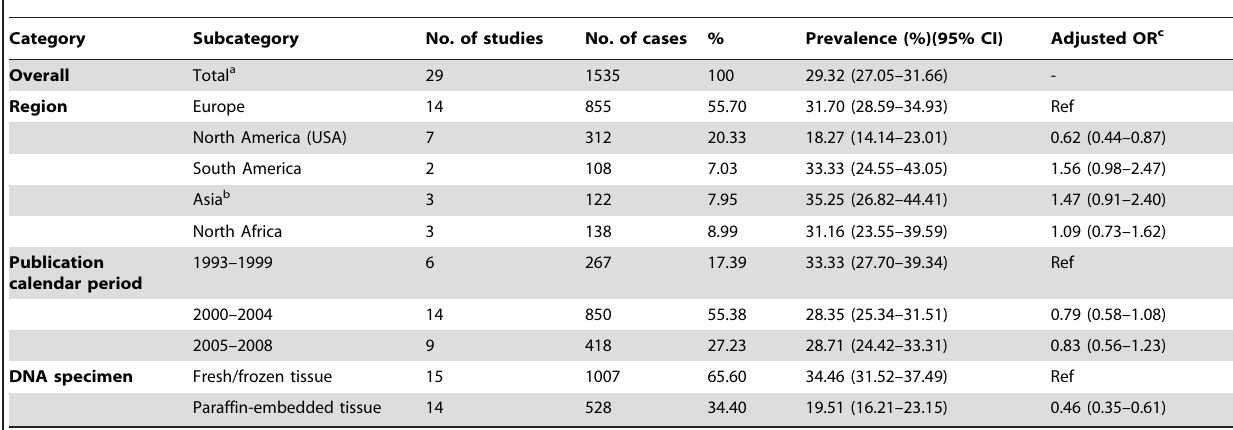
Table 1. EBV prevalence in all types of breast carcinoma